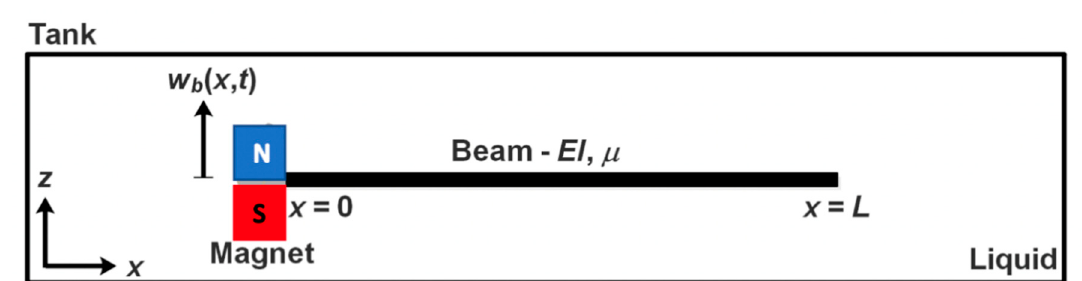
Figure 3. Cantilevered beam immersed in a liquid excited by the translation of its base.